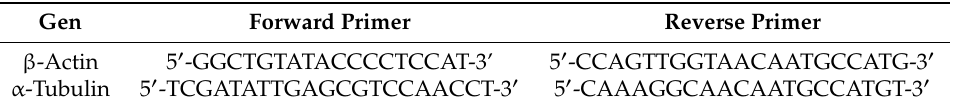
Table 2. Primers sequences used for the indicated murine genes. Gen Forward Primer Reverse